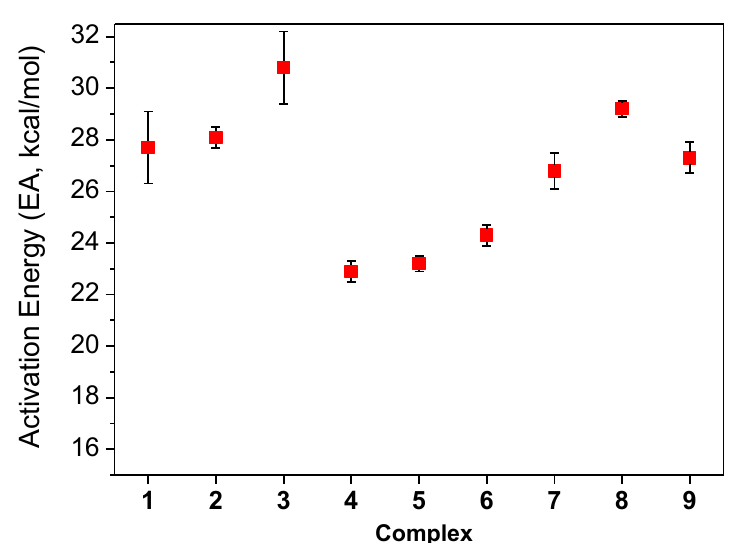
Figure 7. Activation energy (EA, kcal/mol) for the catalytic oxidation of neat toluene by using 0.1 mM of complexes 1 – 9 as catalysts at 100 °C of reaction temperature.